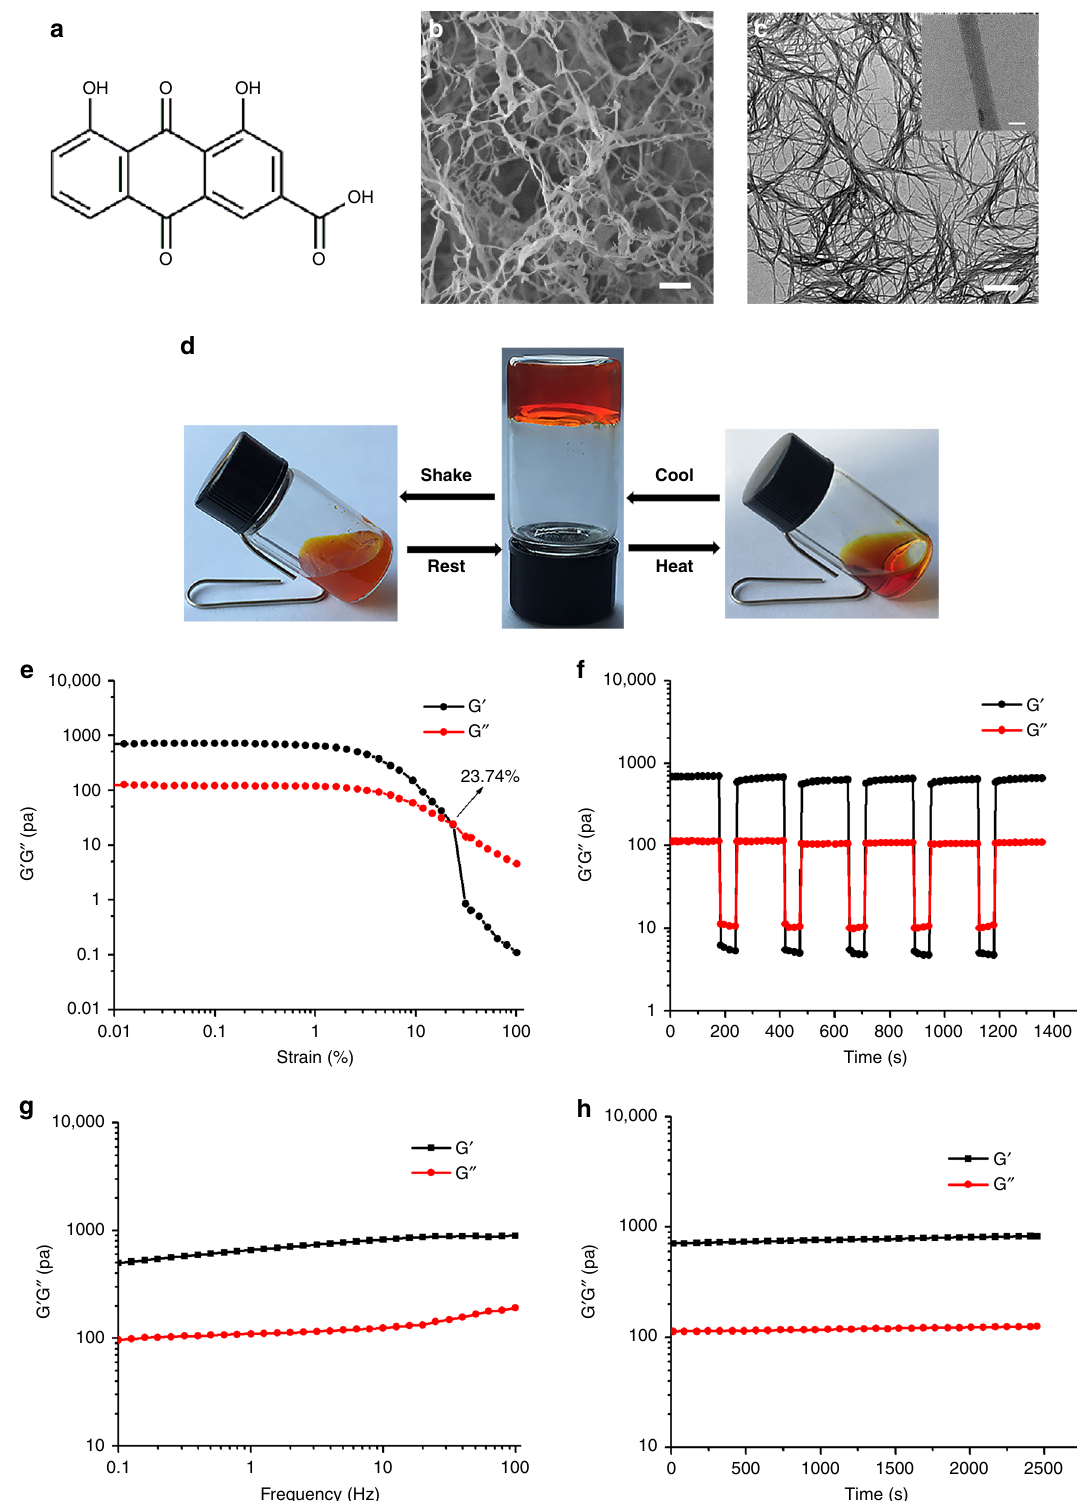
Fig. 1 Molecular formula of rhein and characterization of the rhein hydrogel. a Chemical structures of rhein and digital images of the rhein hydrogel. b SEM image of the rhein hydrogel, scale bar: 2 μ m. c TEM image of the rhein hydrogel, scale bar: 500 nm. The upper right is a partial enlarged view, scale bar: 20 nm. d Reversible gel – sol transitions of rhein hydrogel triggered by shear stress and temperature. e Strain-dependent oscillatory shear rheology of the rhein hydrogel with a fi xed frequency of 10 rad s − 1 . f Step-strain measurements of the hydrogel over fi ve cycles at low strain (0.1%) and high strain (35%), frequency 10 rad s − 1 . g Dynamic frequency sweep of the rhein hydrogel, measured at 0.1% strain. h Dynamic time sweep of the rhein hydrogel, at the strain of 0.1% and at the frequency of 10 rad s − 1 . The concentration of hydrogel was 5 mg mL − 1 (17.6 mM), T = 25